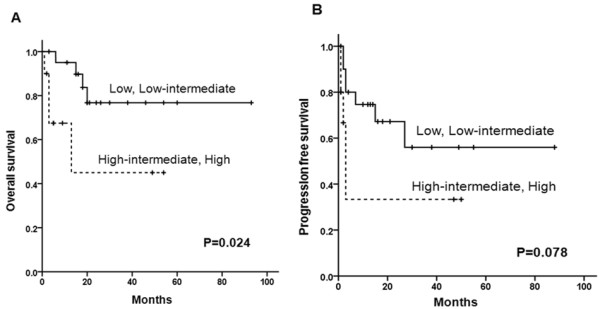
Overall surival (A) and progression-free survival (B) according to the modified IPI score using modified staging system.